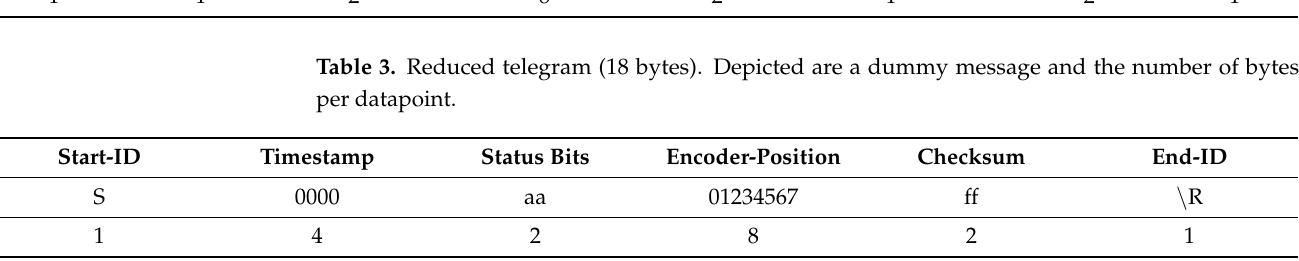
Table 5. Data from the controller to the gateway module.